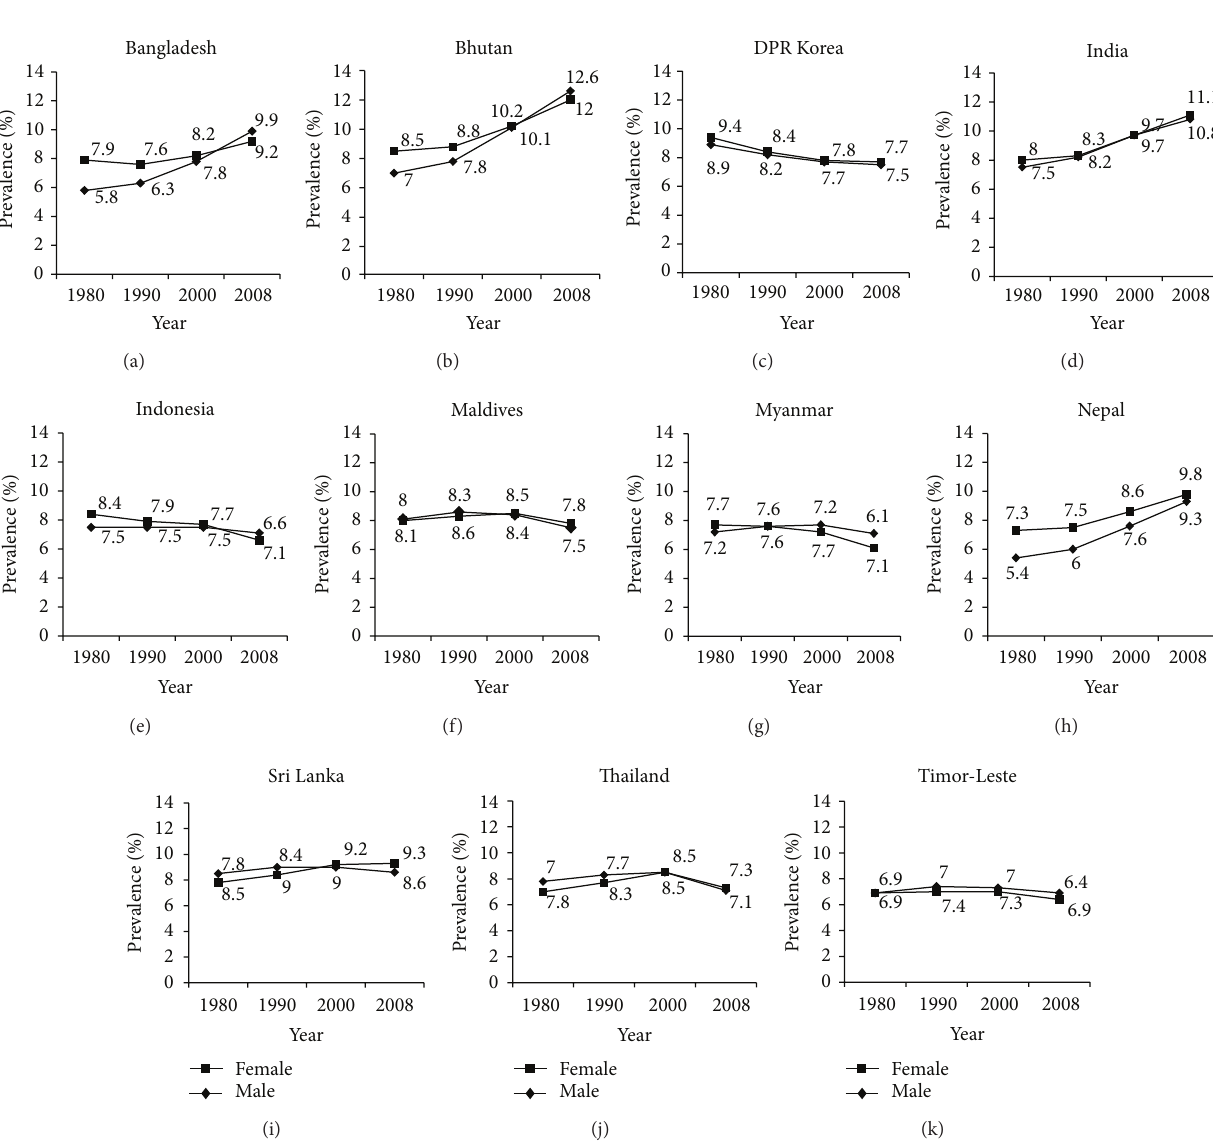
Figure 1: Trends in age-standardised diabetes prevalence in the SEA region between 1980 and 2008 for male and female population